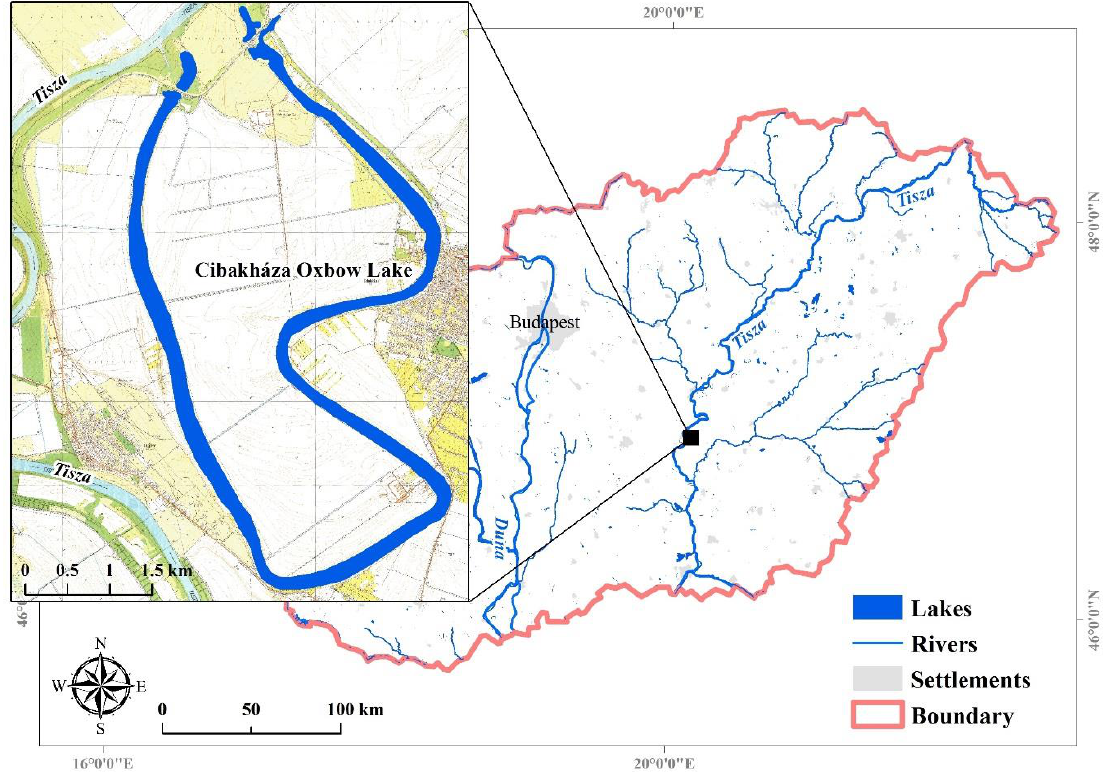
Figure 1. Location of the studied oxbow lake with the markings of lakes, rivers, settlements, and the border of Hungary.